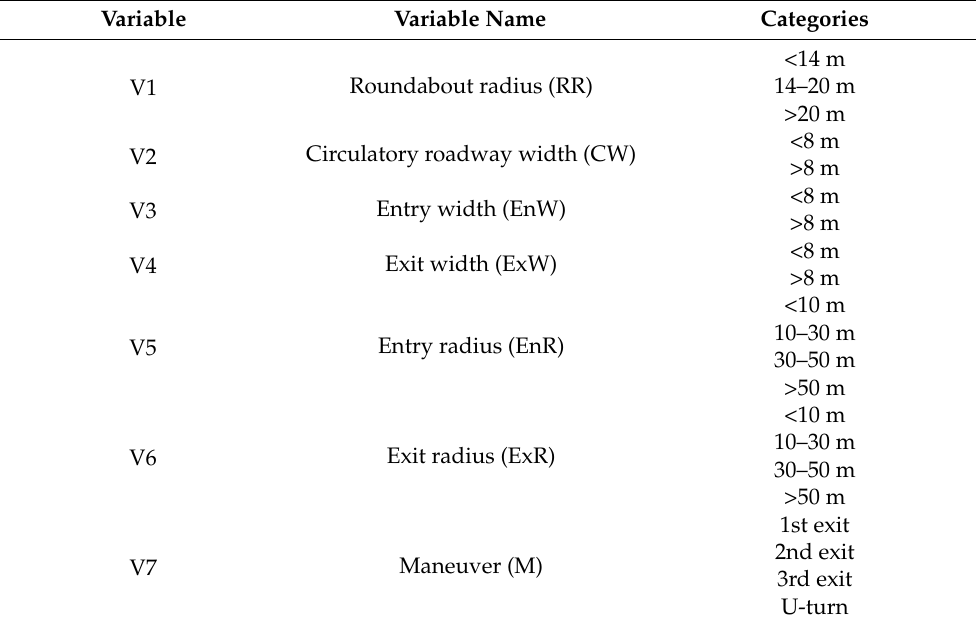
Table 4. CHAID (chi-square automatic interaction detection) analysis independent variables.